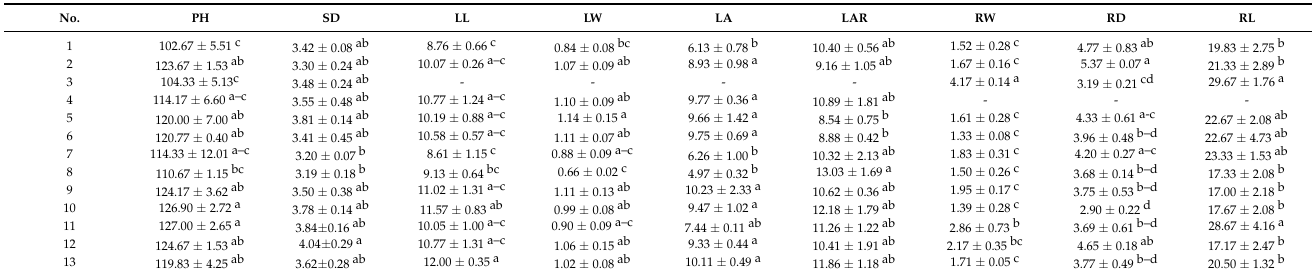
Table 4. Descriptive results of agronomic traits of different Radix bupleuri